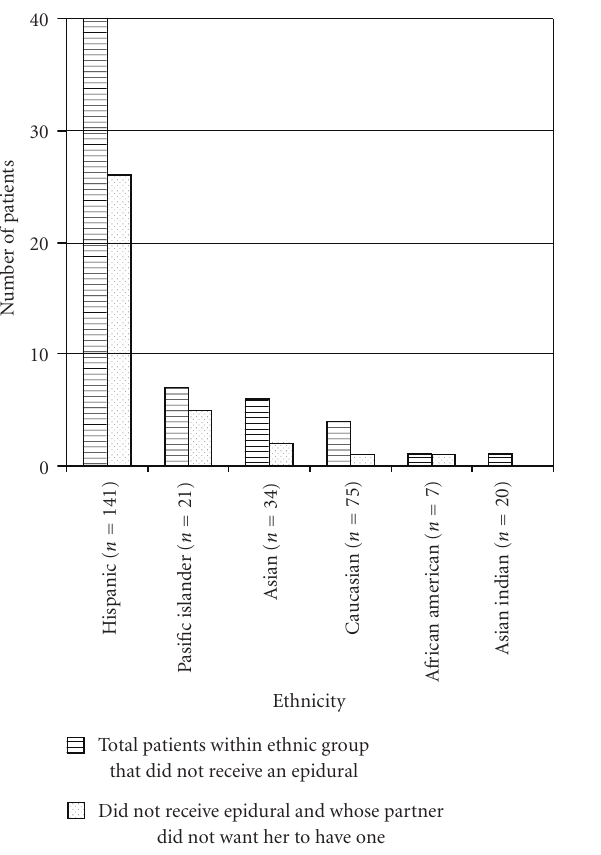
Figure 3: Ethnic group breakdown of women who did not receive epidurals and their partner preference for labor epidurals.